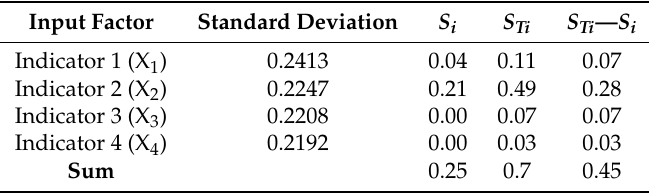
Table 4. Sobol’s first-order and total-sensitivity indices.